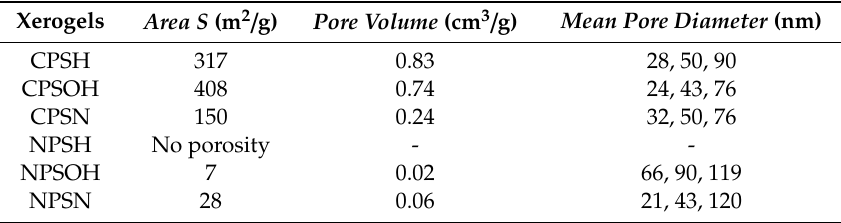
Table 1. Textural properties of the xerogels (BET and